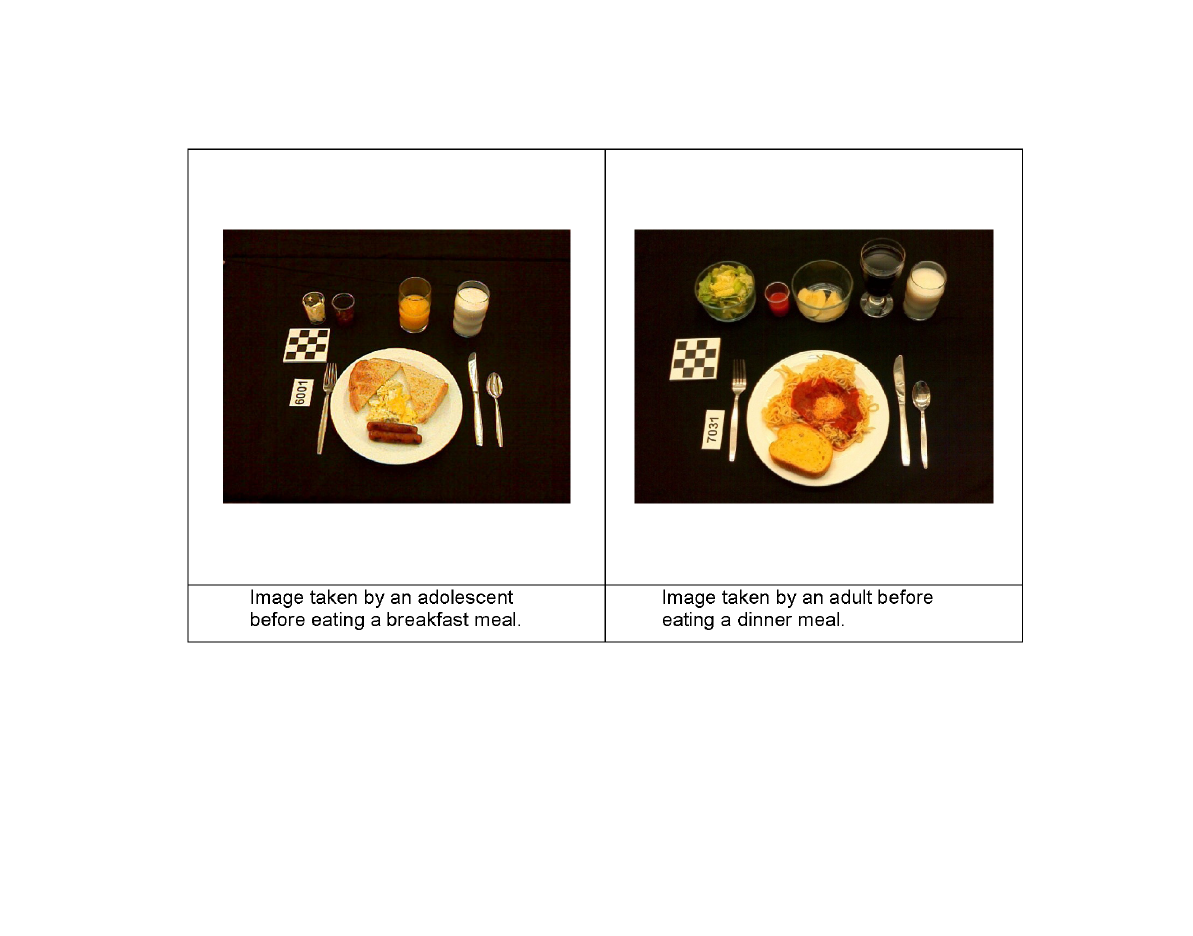
Figure 2. Images that demonstrate meeting two skills required for using the mobile telephone food record: included in the image are all foods and beverages and the entire fiducial marker (checkerboard